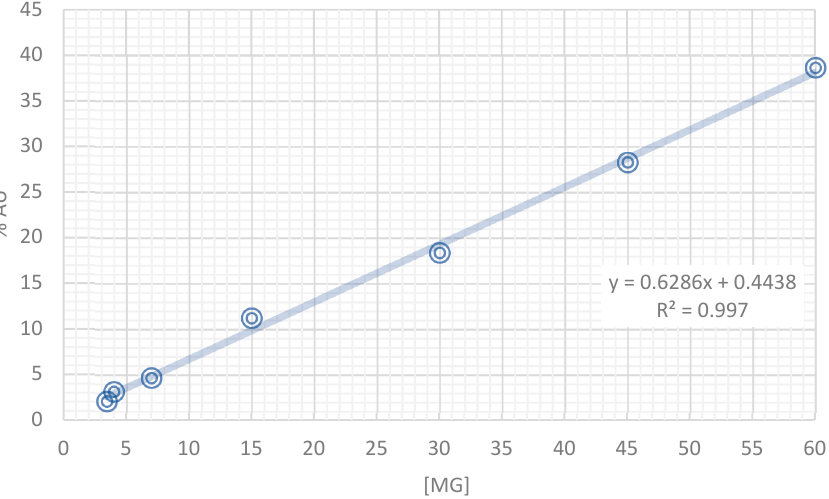
Figure 2. Calibration curve of the standard rutin (the major compound in the tea infusion extracts of Ac ) of high-performance liquid chromatography with diode array detection (HPLC-DAD) analysis at 254 nm. Table 2. The concentration of flavonoids in the tea infusion extracts of Ac throughout of the summer collection.